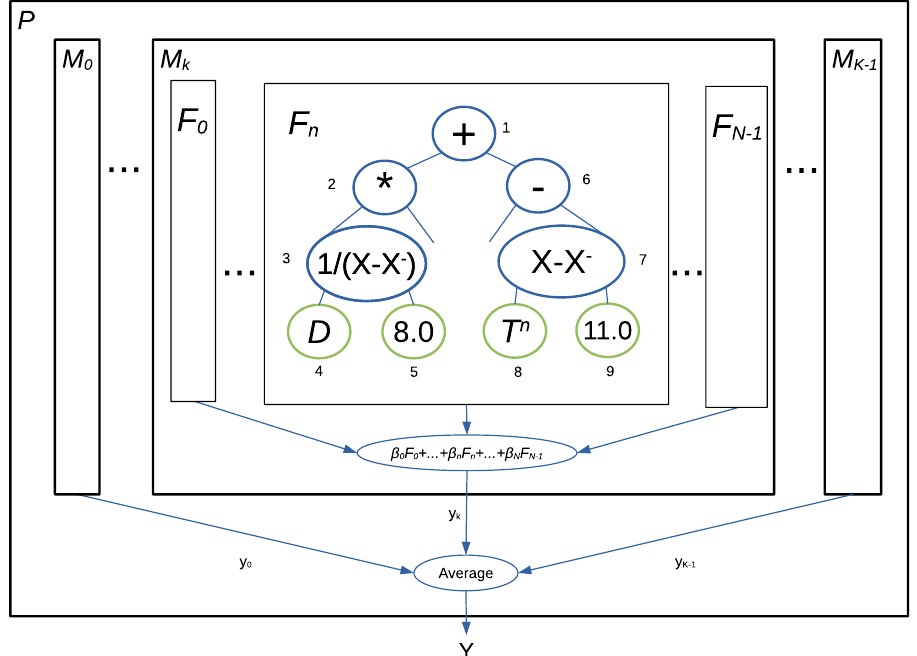
Figure 3. The Pool P of individual models M k , k = 0,..., K − 1 that includes control functions F n , n = 0,..., N − 1 represented as trees with nodes 1, 2, 3, 6, 7 and leaves 4, 5, 8, 9. Nodes contain arithmetic operations and expressions, climatic factors day length D and minimal temperature T n are in leaves 4 and 8, respectively. Leaves 5 and 9 hold base constants for corresponding factors. For simplicity not all nodes are shown and thus some edges from 2 and 6 are unconnected. Triples of dots represent the sequences of the similar